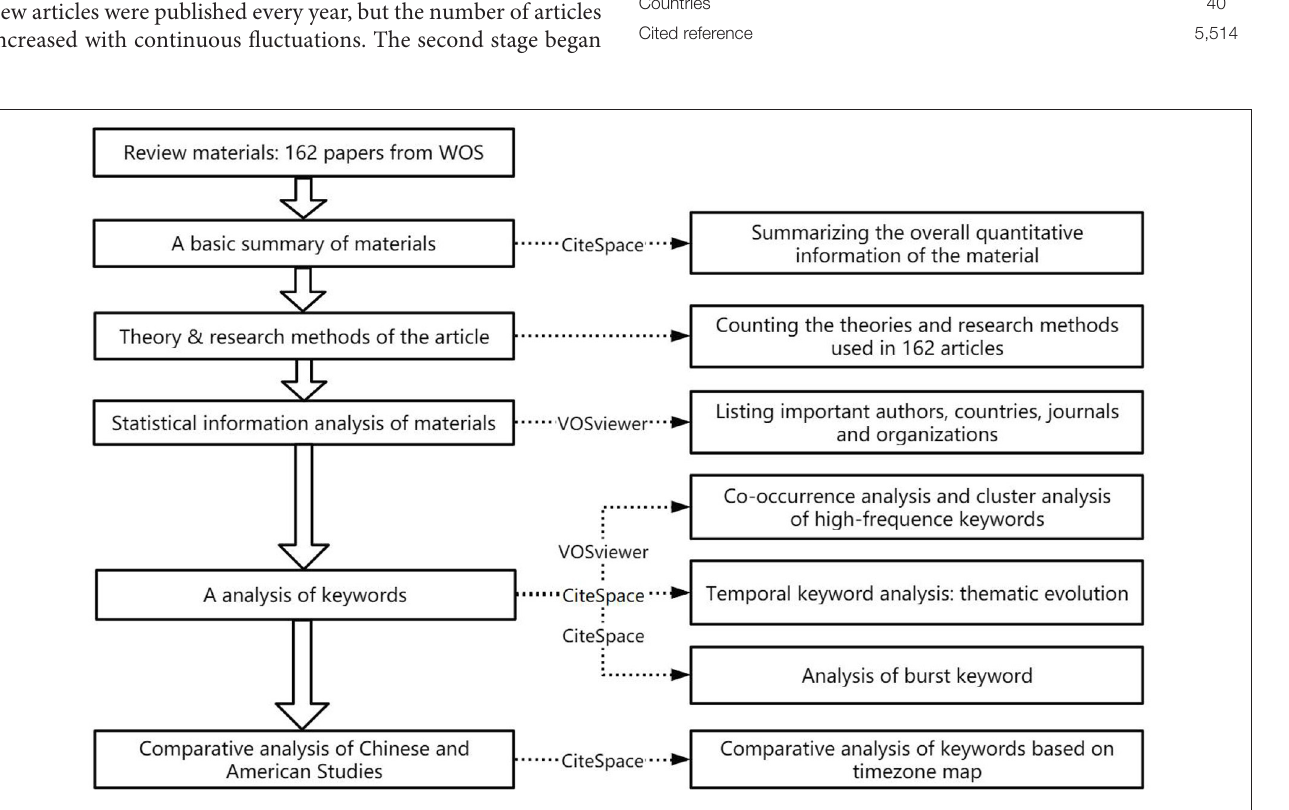
FIGURE 1 | Analytical